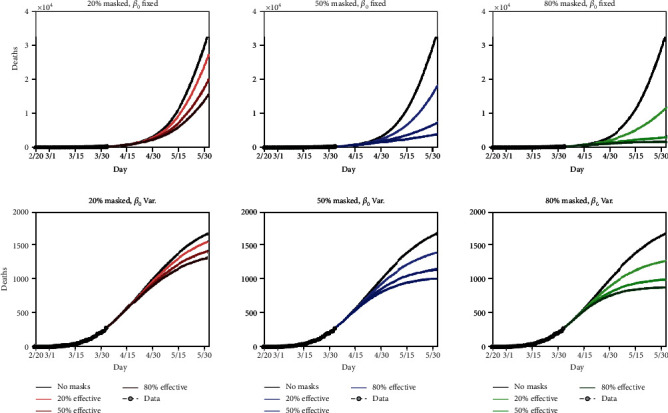
Simulated future (cumulative) death tolls for Washington state, using either a fixed (top panels) or variable (bottom panels) transmission rate, β, and nine different permutations of general public mask coverage and effectiveness. The y-axes are scaled differently in the top and bottom panels. Reproduced with permission from Ref. [18]. Copyright 2020, Elsevier B.V. on behalf of KeAi Communications Co., Ltd.